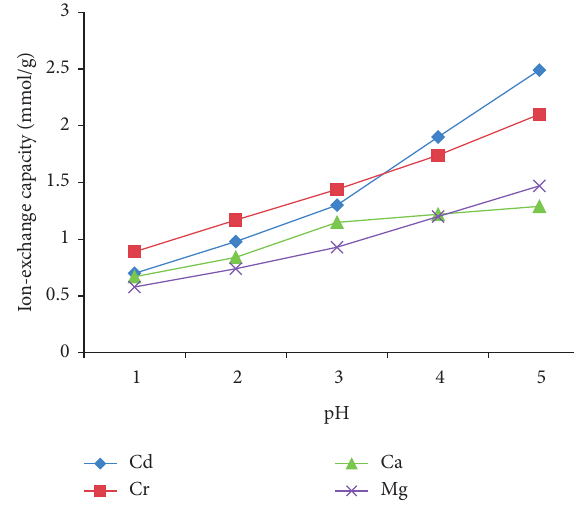
Figure 8: The metal uptake capacity of the Dowex 50-X8 resin as a function of pH.